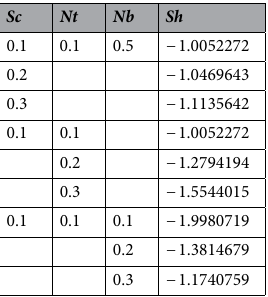
Table 4. Variation of different parameter on Sherwood number.